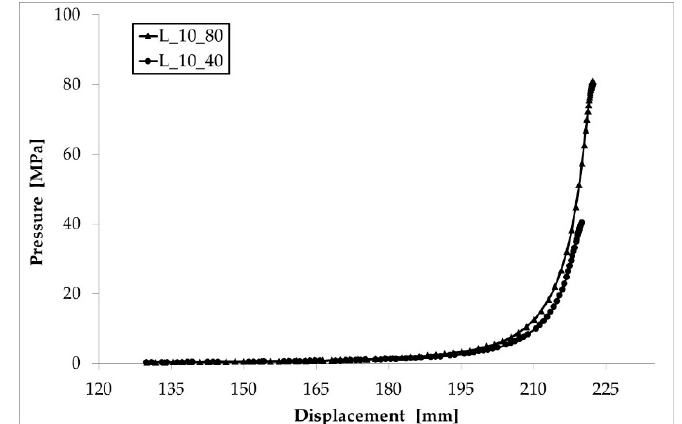
Figure 2. Force-displacement plots recorded during the compression test.